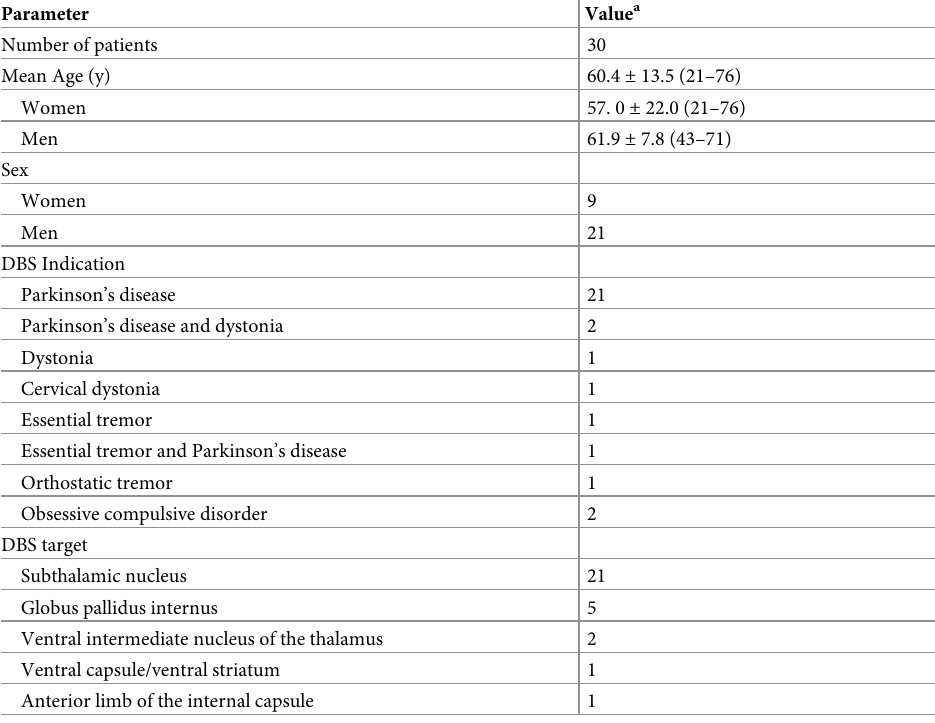
Table 2. Summary of patient